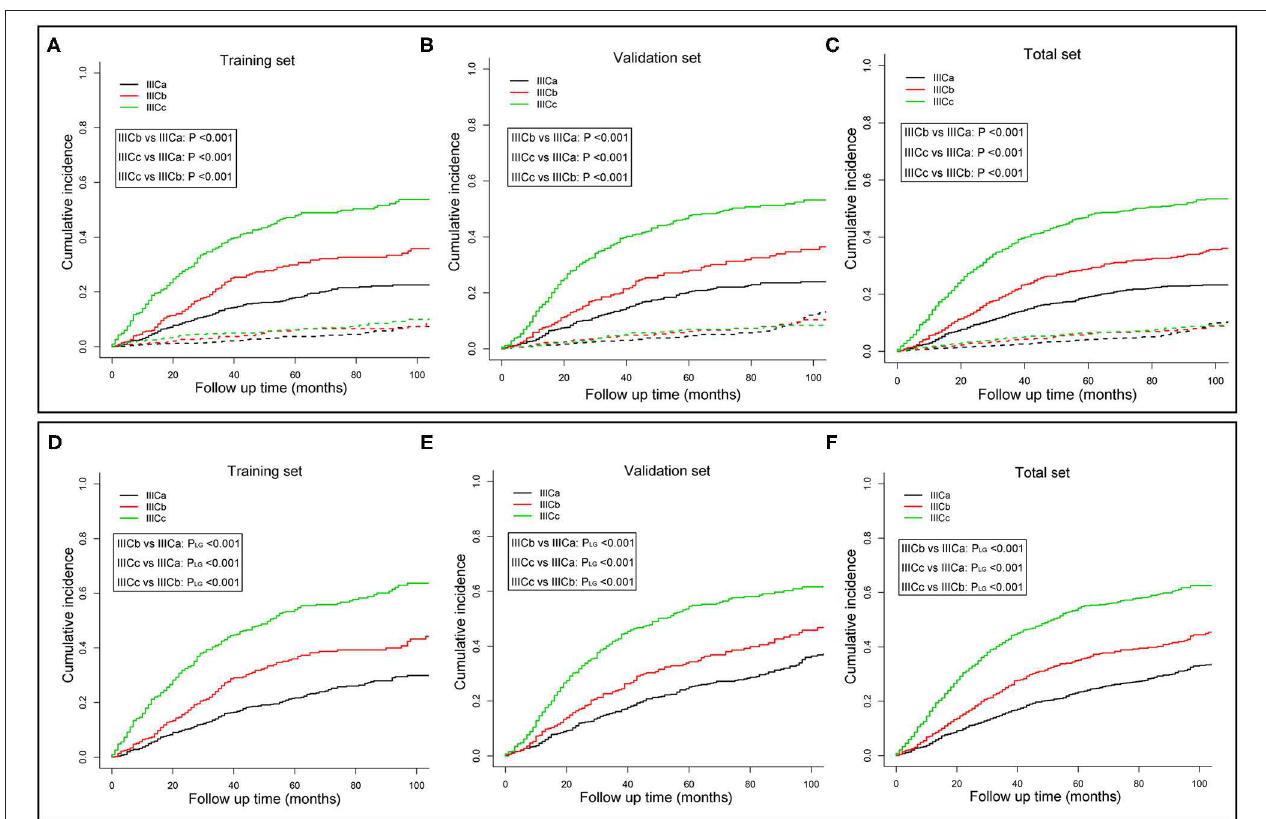
FIGURE 1 | Cumulative incidence curves of cancer-specific mortality (A–C) and all-cause mortality (D–F) for different IIIC subcategories in the training (A,D) , validation (B,E) , and whole sets (C,F) . P -values were compared using Gray’s test (A–C) or log-rank test (D–F) . The solid and dashed lines in A – C denote cancer-specific death (CSD) and non-cancer specific death (non-CSD). IIICa consists of patients with T1N1 or T1N2; IIICb consists of patients with T2N1 or T2N2; IIICc consists of patients with T3N1 or T3N2.